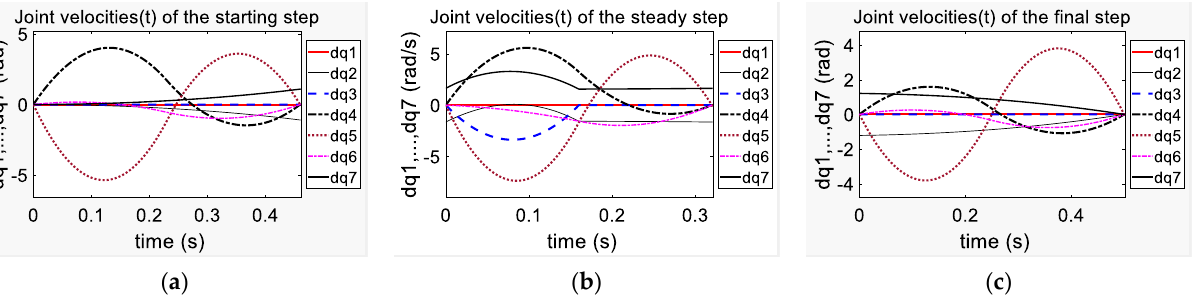
Figure 8. The motion of robot link: the joint velocities (t) in the starting ( a ), steady ( b ), and final ( c ) steps.